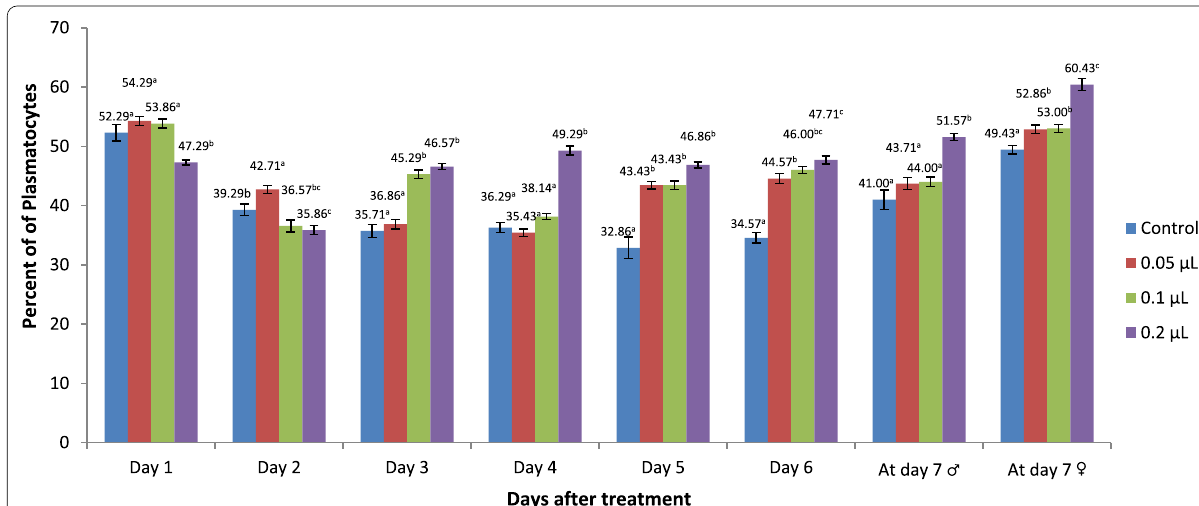
SE, Seven replicates were taken ±